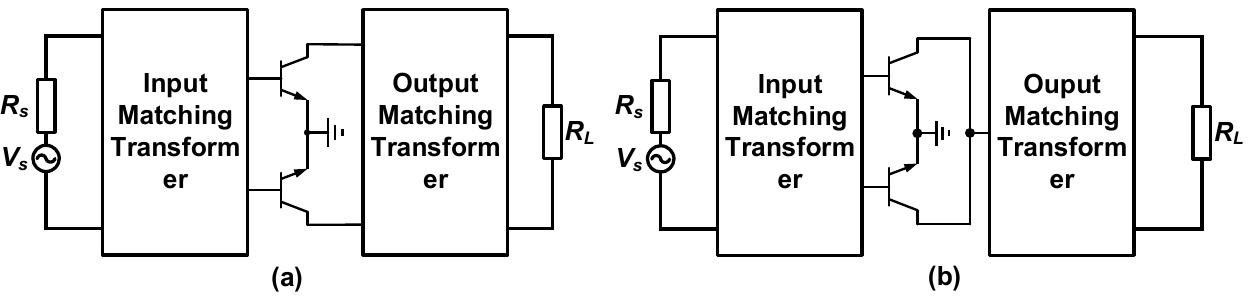
Figure 6. ( a ) Block diagram of the input buffer circuit. ( b ) Block diagram of the frequency multiplication circuit.